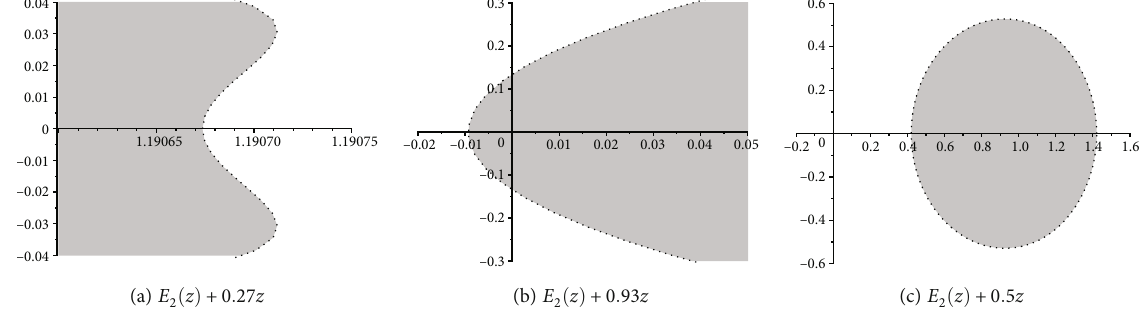
Figure 2: E μ ð U Þ for three di